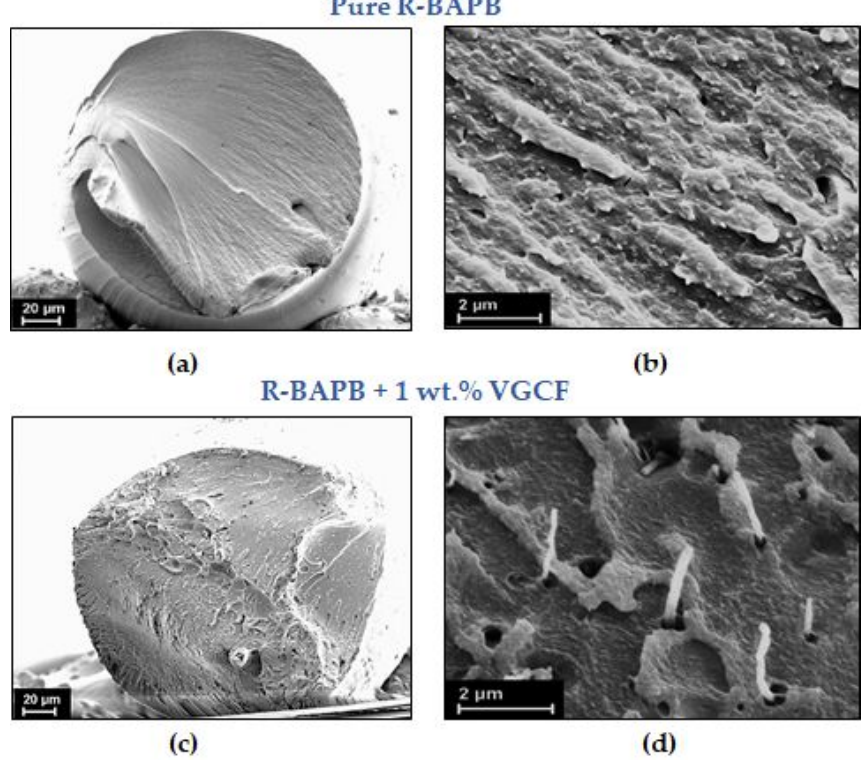
Figure 3. SEM images at different magnification of cryo-cleavages of the unoriented amorphous fibers (DR = 1) based on R-BAPB polyimide with the addition of 1 wt.% VGCF. ( a , b ) the pure R-BAPB fiber, ( c , d ) the composite R-BAPB fiber filled with 1 wt.% VGCF.